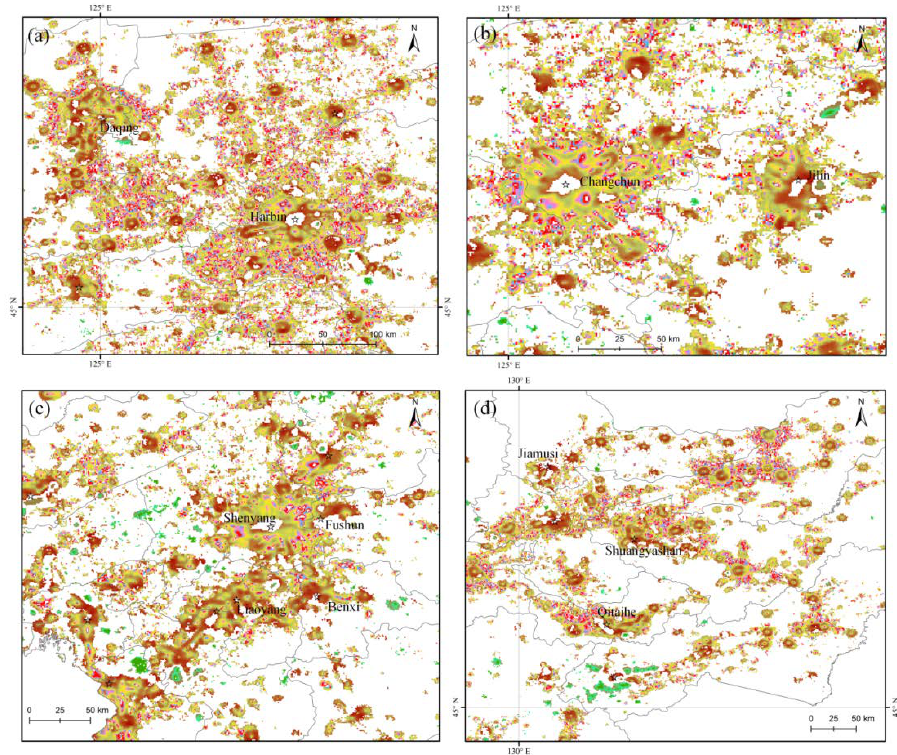
Figure 5. the NTL velocity for main urban agglomeration . a, Harbin. b, Changchun-Jilin. c, Shenyang. d, small cities such